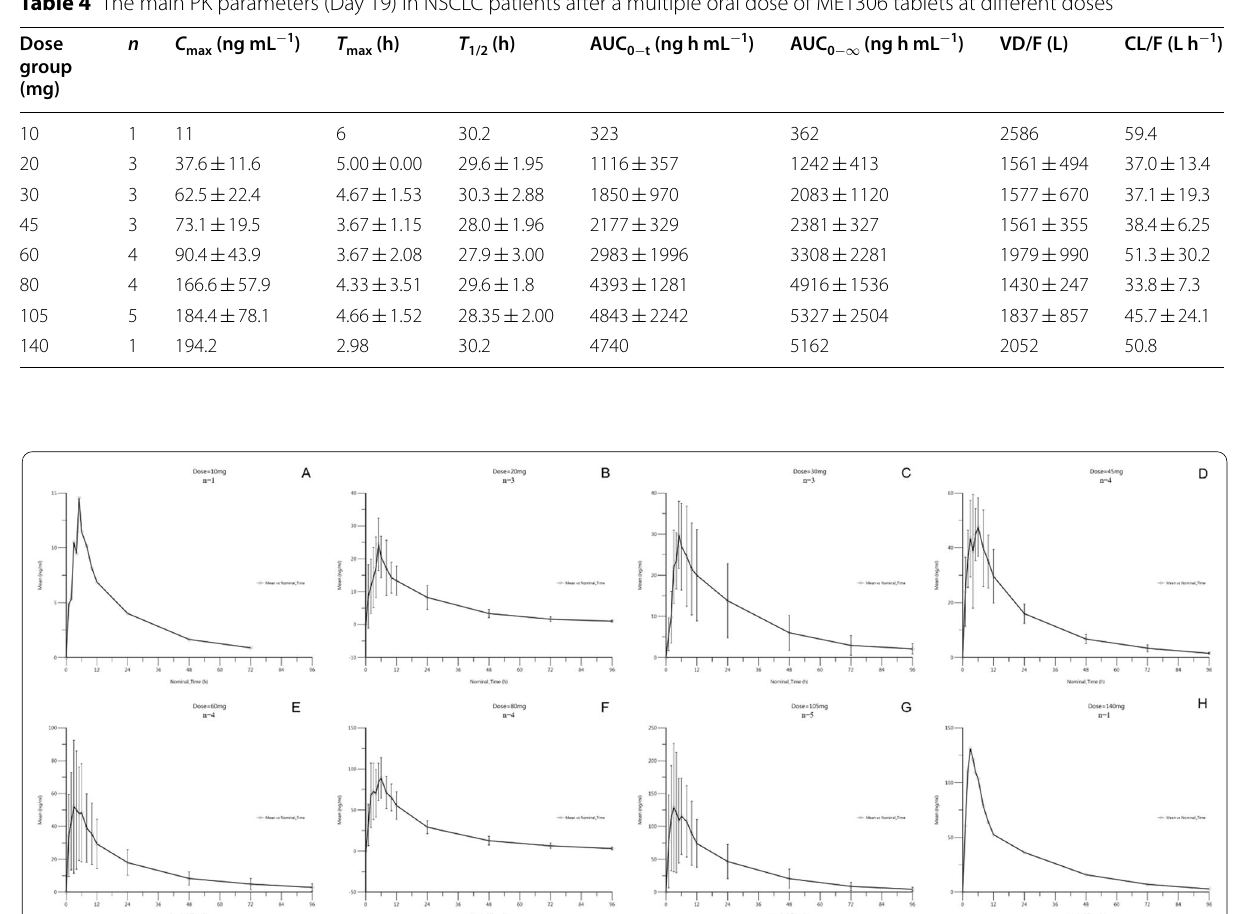
SD ± 1, B : n 3, C : n 3, D : n 4, E : n 4, F : n 4, G : = = = = = =